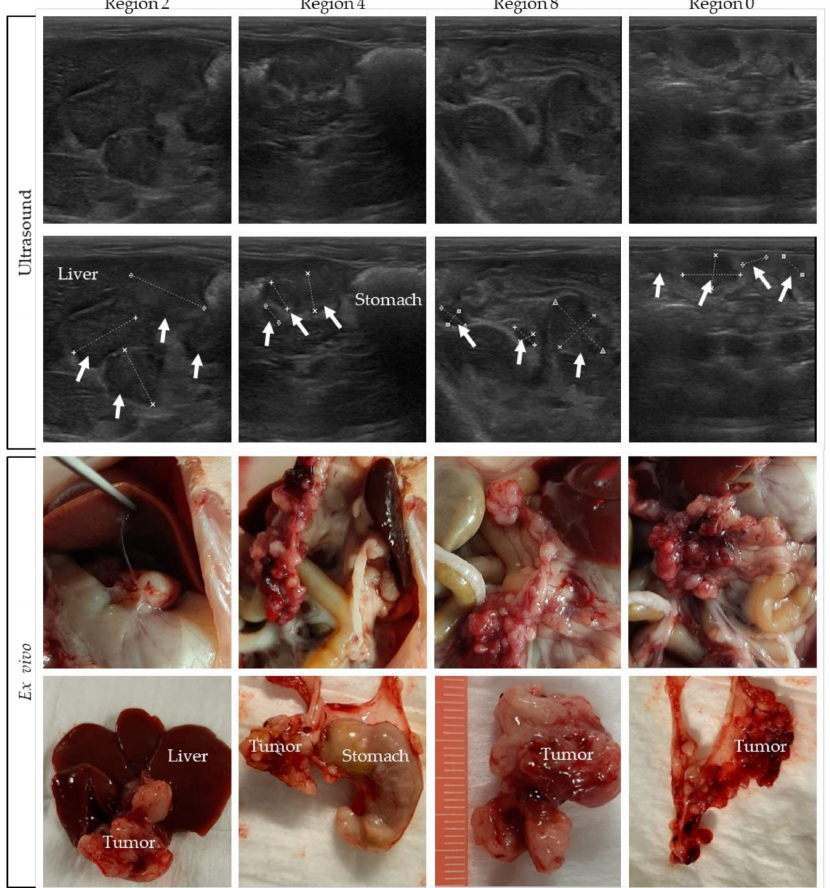
Figure 6. Tumors on ultrasound compared to the ex vivo tumor load. Tumor lesions are indicated with white arrows, and organs are